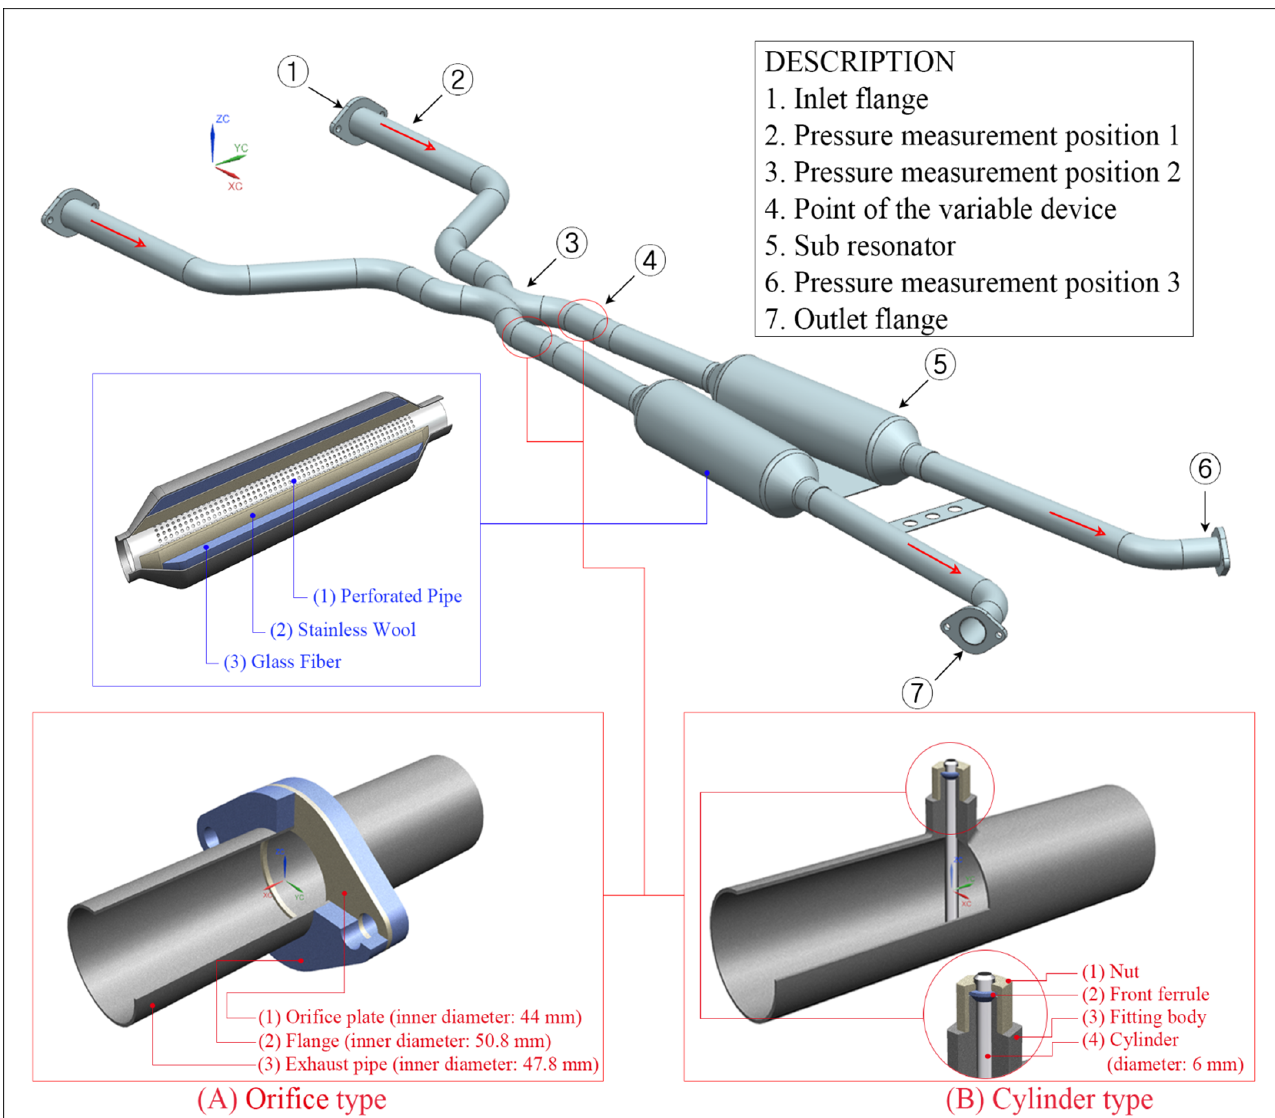
Figure 1. Description and schematic diagram of the designed exhaust system and variable device. ( A ) Designed orifice valve type; ( B ) Designed cylinder type.